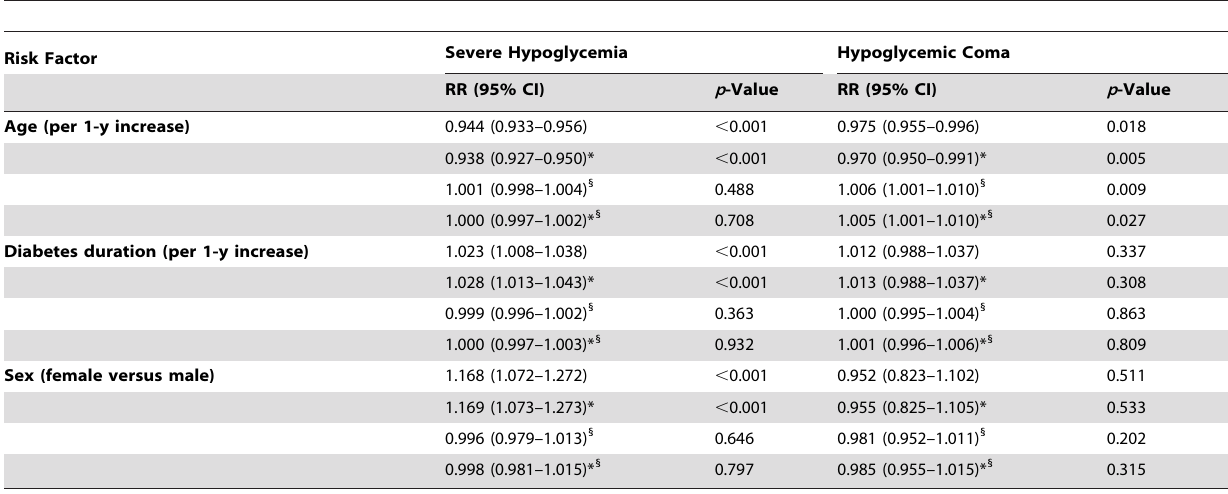
Table 4. Association of age, diabetes duration, and sex with severe hypoglycemia and hypoglycemic coma for 1995–2012, expressed as relative risk and annual change in relative